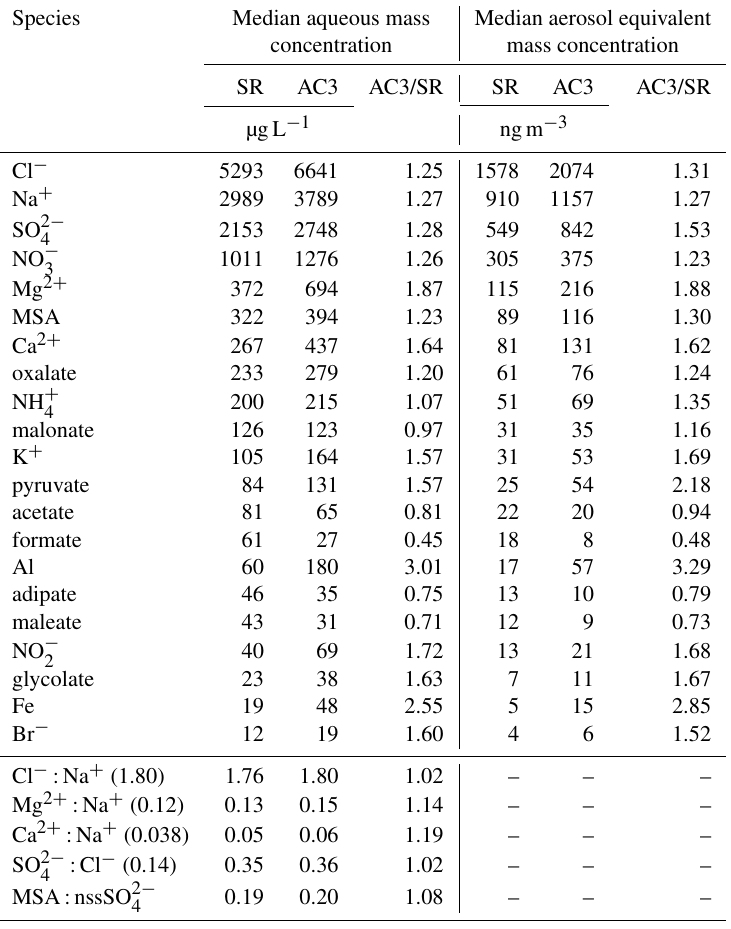
Table 5. FASE campaign major species mass concentrations and selected ratios between the AC3 and the slotted rod (SR).